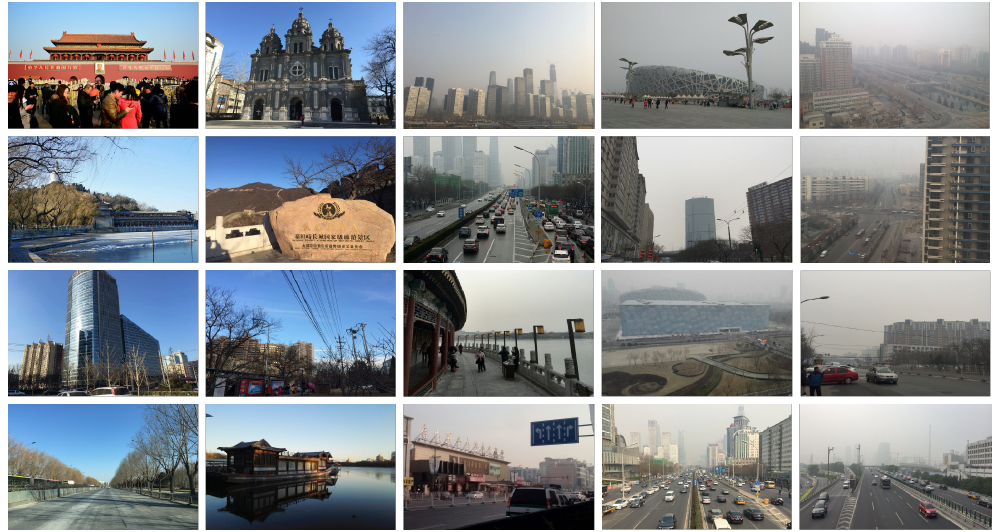
Figure 5. Examples of partial samples in